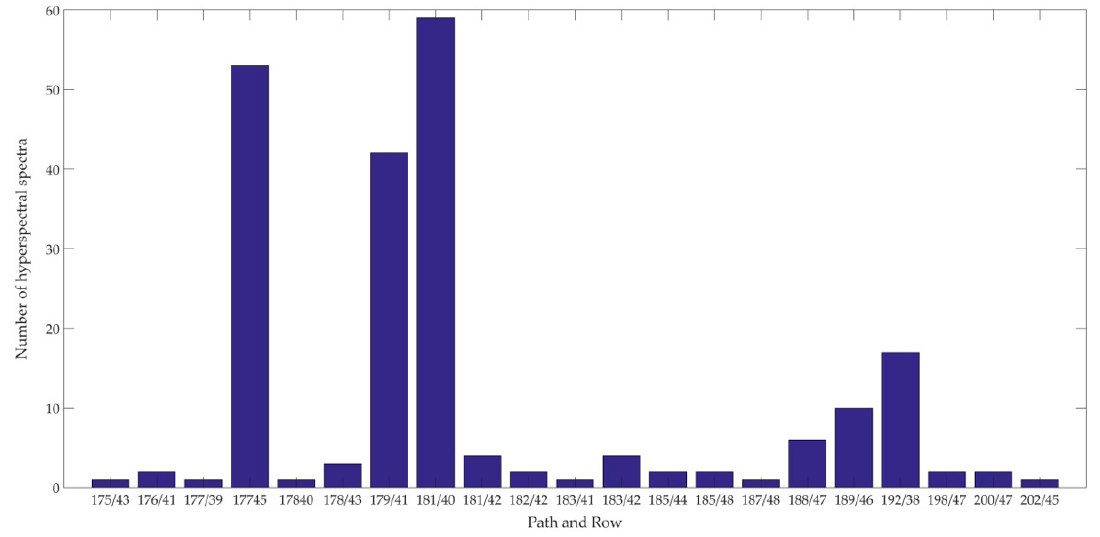
Figure 5. Number of hyperspectral spectra corresponding to each WRS-2 Paths and Row of Cluster 13.